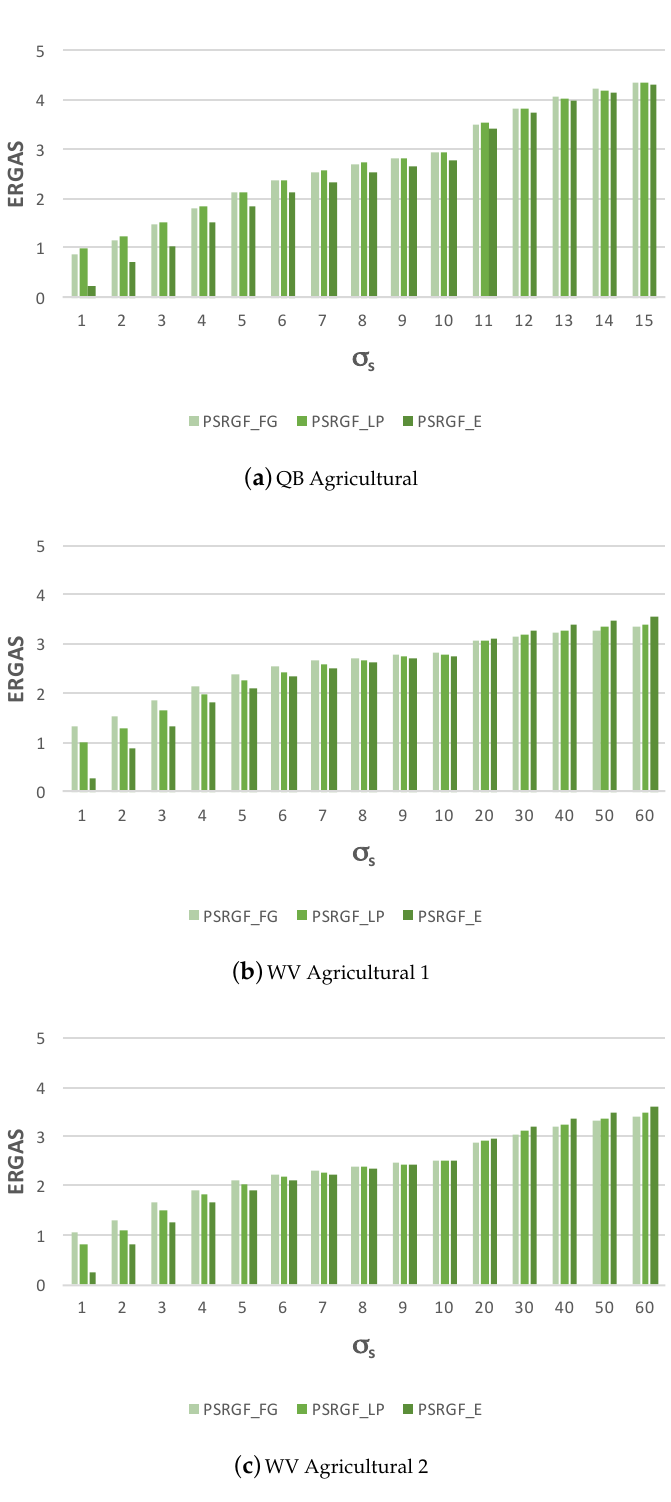
Figure 5. ERGAS index behavior: ( a ) PSRGF FG ; ( b ) PSRGF LP and ( c ) PSRGF E methods for different σ s